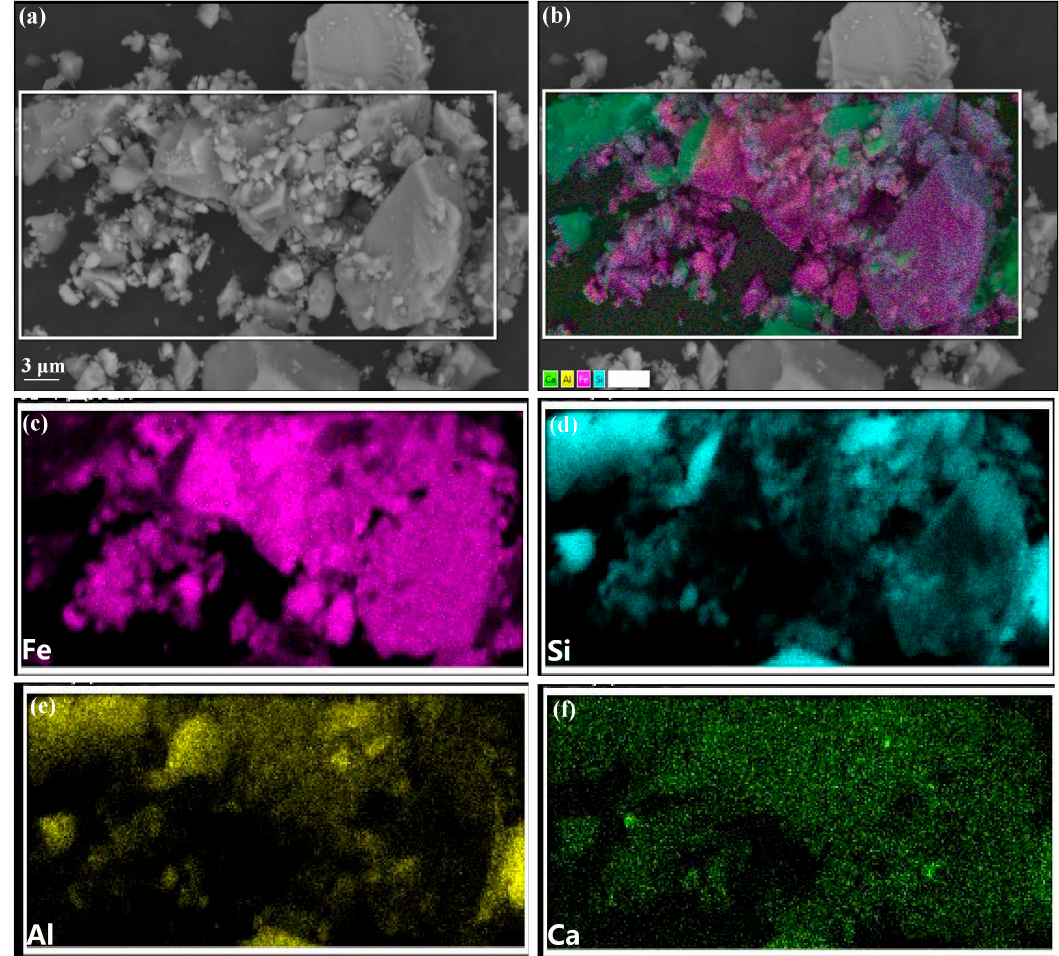
Figure 3. The SEM-EDS mapping of copper slag sample: ( a ) SEM micrograph; ( b ) SEM-EDS mapping micrograph; ( c ) Fe element distribution; ( d ) Si element distribution; ( e ) Al element distribution; and ( f ) Ca element distribution. ( a – f ) scale bar is 3 μ m.